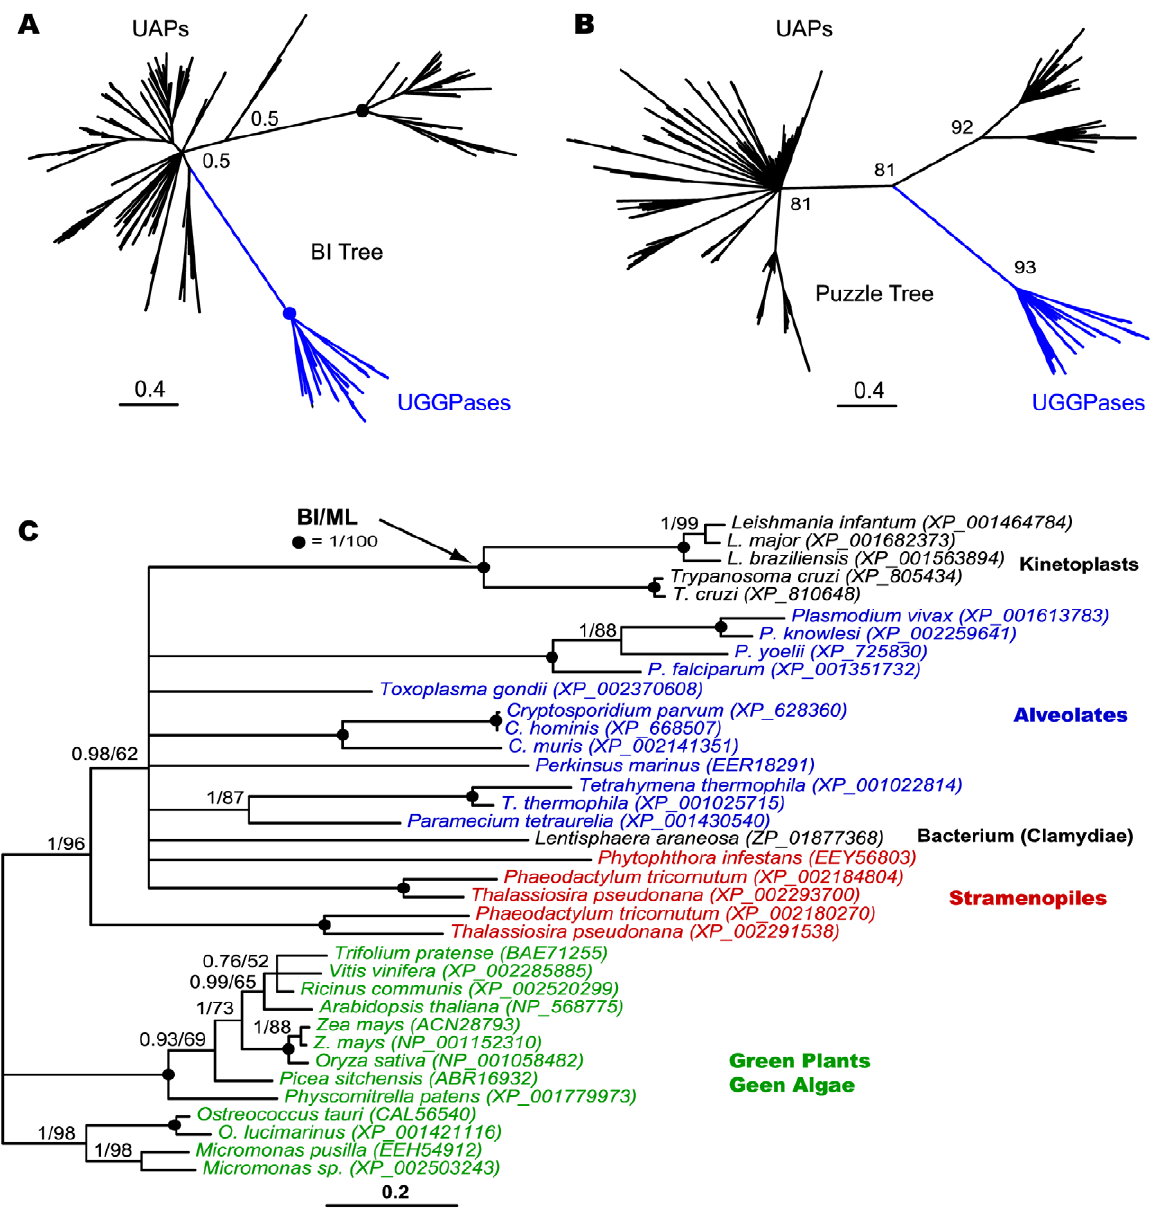
Figure 5. Phylogenetic relationship of apicomplexan UDP-glucose/galatose pyrophosphorylase (UGGPase) among glucosyltrans- ferase family A (GTA) proteins including UDP- N -acetylglucosamine pyrophosphorylases (UAPs). A ) Tree derived from 224 GTA taxa by Bayesian inference (BI) with posterior probability values indicated at major nodes. B ) Maximum likelihood (ML) tree derived from 224 GTA taxa by quartet puzzling method with quartet puzzling support values indicated at major nodes. C ) Trees inferred from 93 taxa containing only UGGPase sequences by BI and ML methods using MrBayes and TreeFinder programs, respectively. Numbers at nodes are posterior probability (PP) and bootstrap (BP) supporting values determined by BI and ML analyses. Solid circles indicate nodes with 100% supports by both PP and BP values.